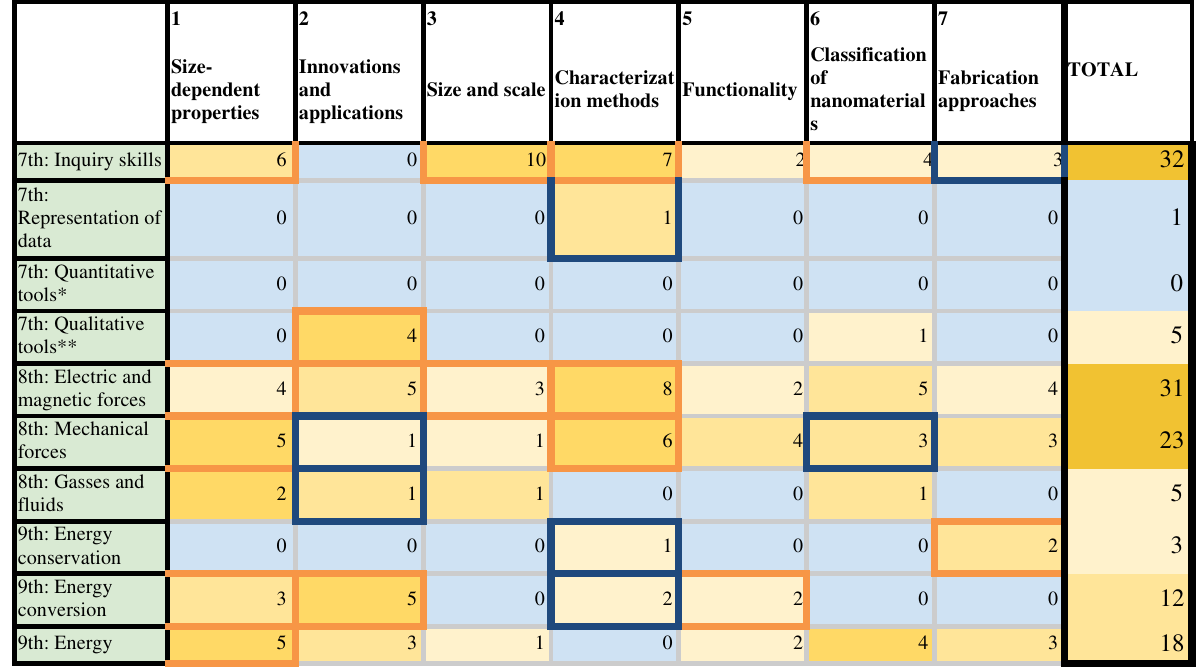
FIG. 4. “ Heat map ” - the number of connections made between NST concepts and specific curricular topics. A “ warmer ” color (more orange) indicates more insertion points per concept and topic. Bold orange frames represent connections that were strongly supported by the teacher during the validation process. Bold blue frames represent connections the teacher opposed. No frame means the teacher agreed with the insertion point but did not make any comment on the connection during the validation process. *Quantitative tools: representing physical phenomena by formula or other mathematical expressions, for example, velocity, V ¼ Δ x= Δ t . **Qualitative tools: representing or describing physical phenomena by using natural laws. Example: the energy conservation law and how we can use it to predict in words the motion of a ball thrown